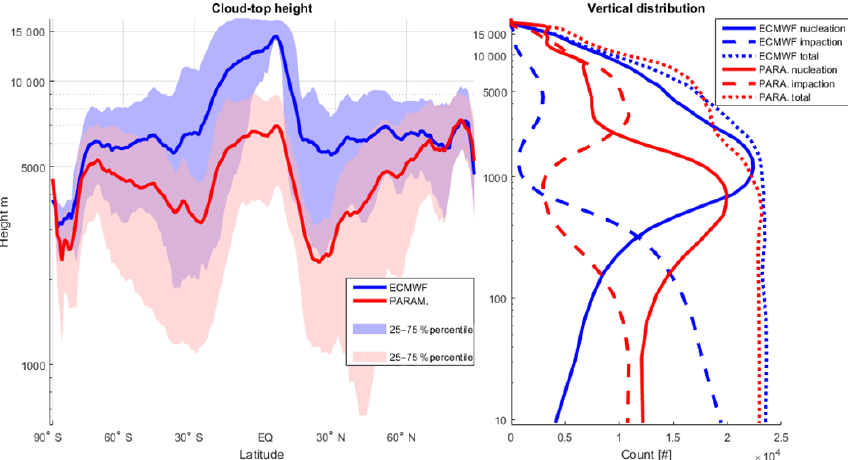
Figure 3. Left: the zonally averaged median cloud top heights of precipitating clouds as a function of latitude, averaged over a 90-day period starting in December 2006. Clouds are defined using either the FLEXPART relative humidity-based parameterization (red line) or by CTWC data (blue line). The shaded areas span the 25–75 percentiles. Right: number of potential removal events globally, for in-cloud nucleation scavenging (solid lines), below-cloud impaction scavenging (dashed lines) and the sum of the two (dotted lines), for both the parameterized clouds (red lines) and when ECMWF cloud water fields are used (blue lines). Note that the height scales are different for the left and right panels.